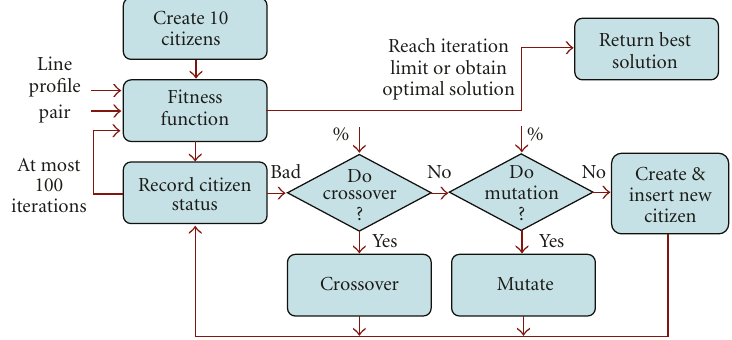
Figure 3: Dataflow of genetic